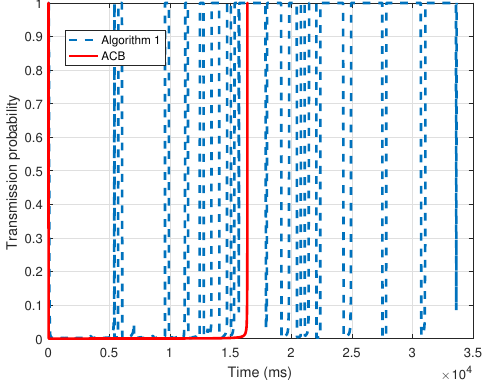
Figure 5. Transmission probability vs.